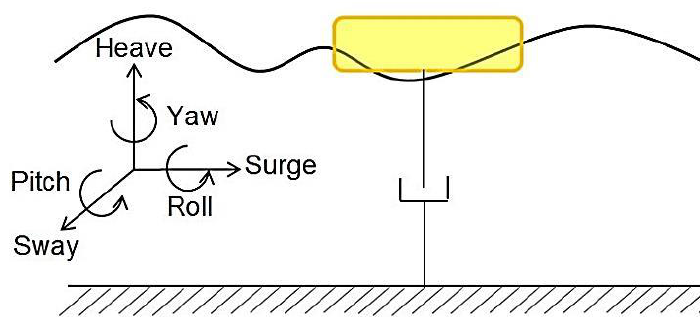
Figure 8. Model of wave motion.